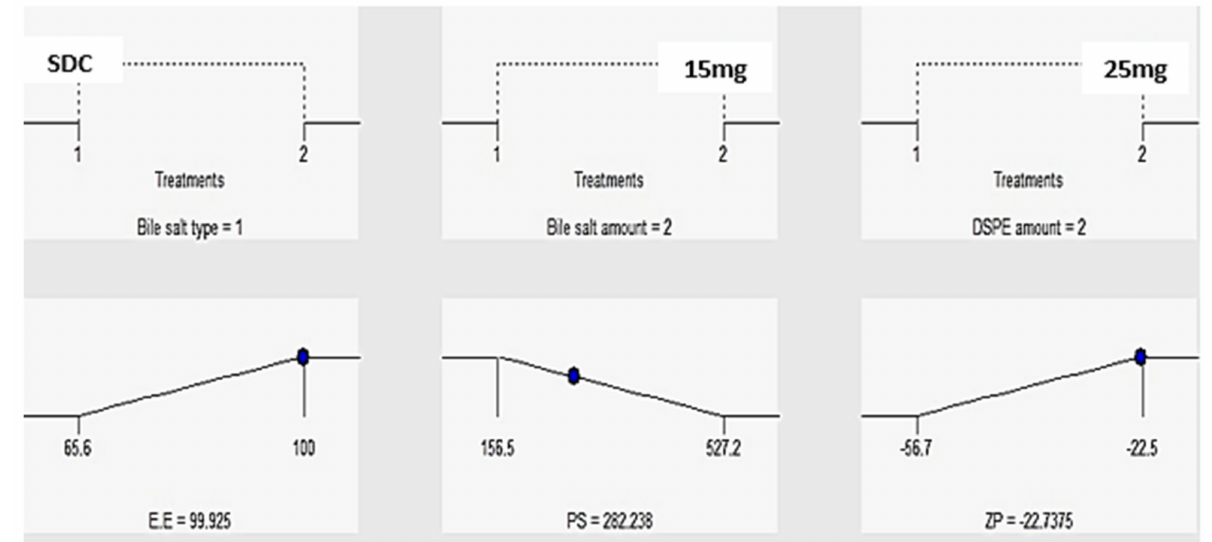
Figure 12. Optimization ramps for the studied independent variables exploit the optimum criteria of the formulation variables for 4e -PEGylated bilosomal formulae with the predicted value of each measured formulation